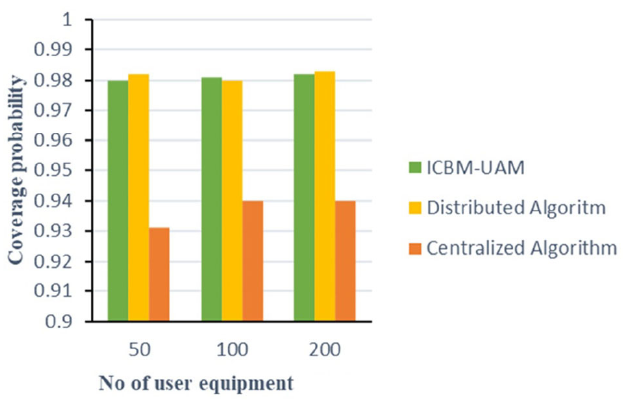
Figure 14. Coverage probability without obstacles.